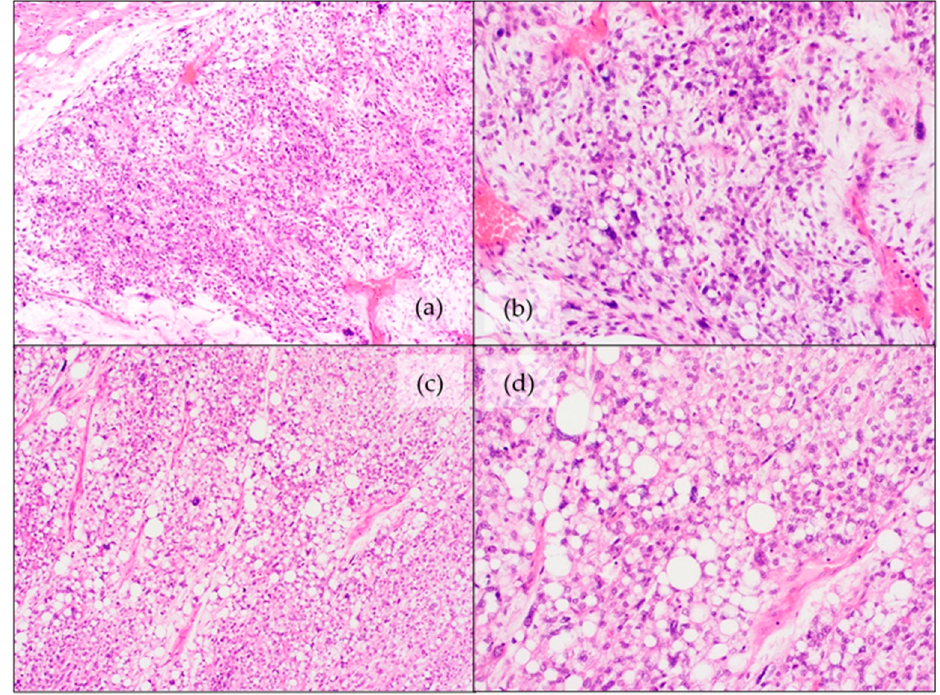
Figure 4. Histomorphological features of pleomorphic liposarcoma: ( a , b ) Overview and detail images with sporadic, pleomorphic lipoblasts (H&E staining); ( c , d ) Overview image and magnified displaying more pronounced pleomorphic lipoblasts (H&E staining).